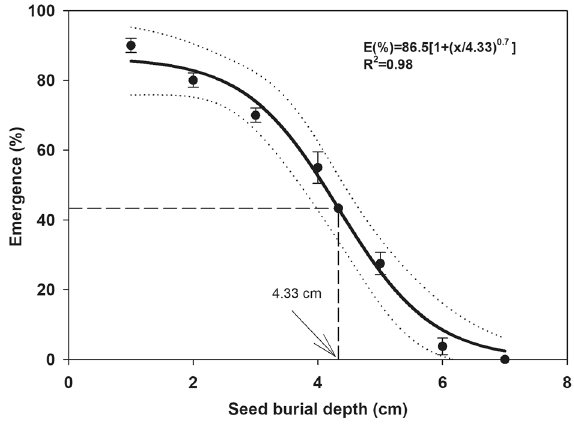
Figure 5. Influence of seed burial depth on seed emergence of perennial ryegrass.. Bold line represents a three-parameter logistic model (E (%) = E max /[1 + (x/x 50 ) g ]) fitted to the data. The vertical dash line represents X-axis value at 50% of the maximum germination. Dotted liens show 95% confidence intervals. Vertical bars represent ± standard error of the mean. No emergence was recorded at 0 cm seed burial depth so, the data of 0 cm were not included in the fitted